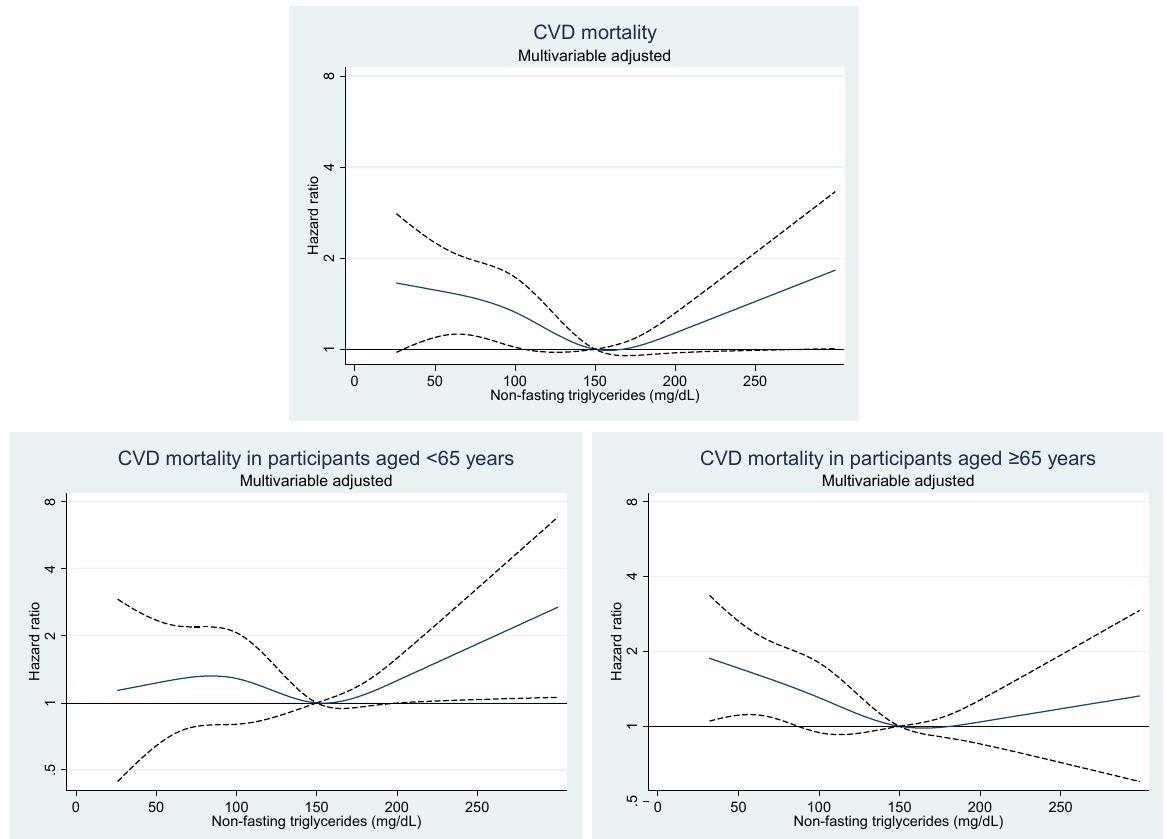
Figure 1. Multivariable-adjusted hazard ratios of non-fasting triglyceride levels for CVD mortality in all participants and in those aged < 65 and ; 65 years. Adjusted variables were age, body mass index, total cholesterol, high-density lipoprotein cholesterol, hypertension, diabetes, smoking status, and alcohol drinking status. Non-fasting TG of 150mg / dL was used as a reference with restricted range of non-fasting TG levels : 300mg / dL. CVD, cardiovascular disease; TG,